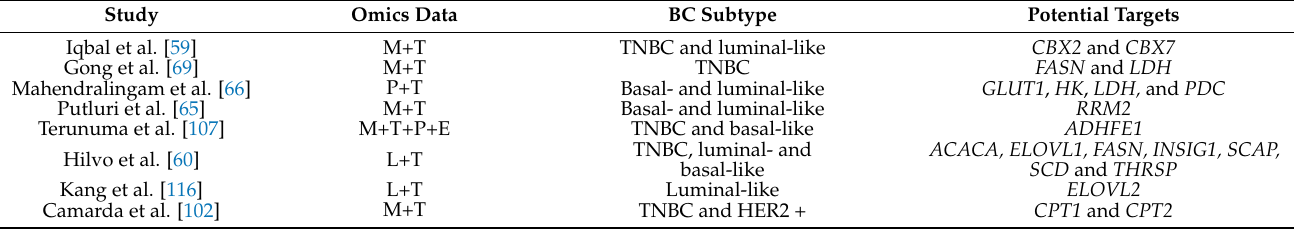
Table 4. Multi-omics studies focused on developing new therapeutic strategies for the treatment of BC.